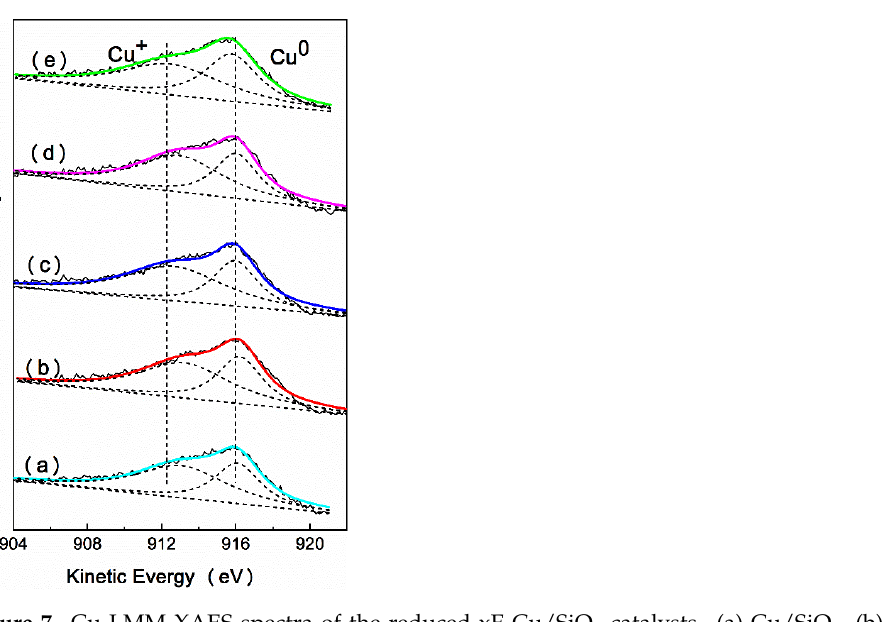
Figure 7. Cu LMM XAES spectra of the reduced xE-Cu/SiO 2 catalysts. (a) Cu/SiO 2 , (b) 0.04E-Cu/SiO 2 , (c) 0.08E-Cu/SiO 2 , (d) 0.12E-Cu/SiO 2 , (e) 0.3E-Cu/SiO 2 . Table 2. Surface Cu species of the reduced xE-Cu/SiO 2 catalysts derived from Cu LMM XAES spec- tra.